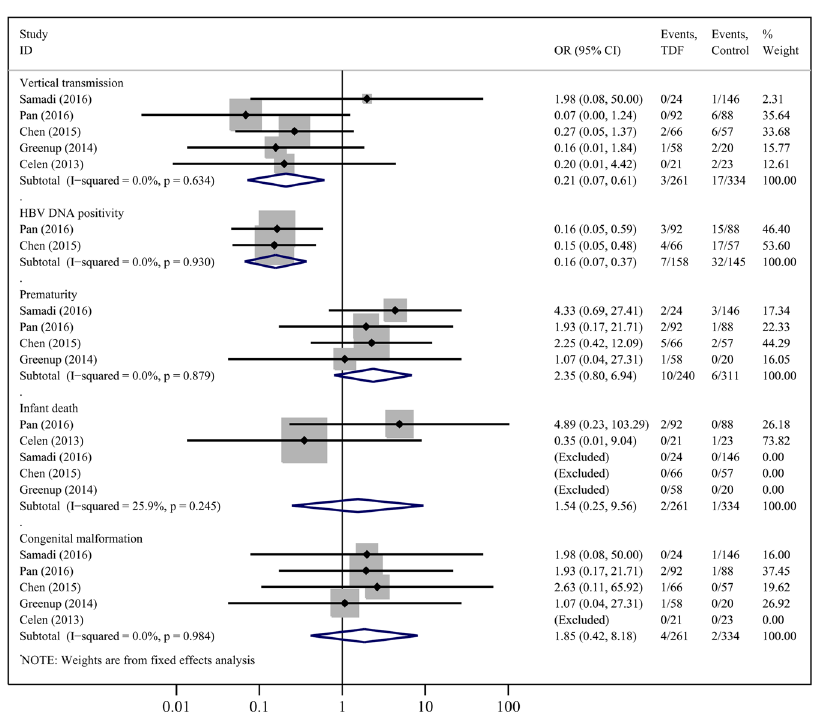
Figure 5. Forest plot showing meta-analysis of infant outcomes for studies comparing TDF versus control, based upon fixed-effects